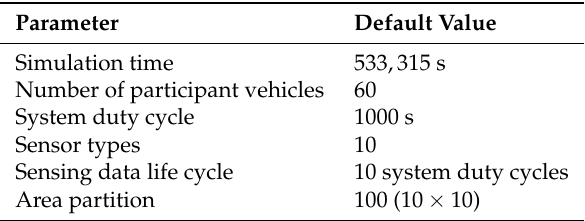
Table 2. Simulation